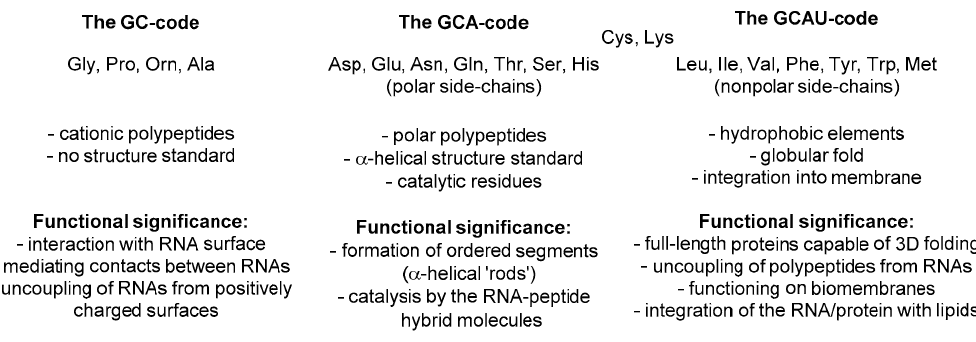
Figure 4. The increasing complexity of the polypeptide structures and functions along the GC–GCA– GCAU development